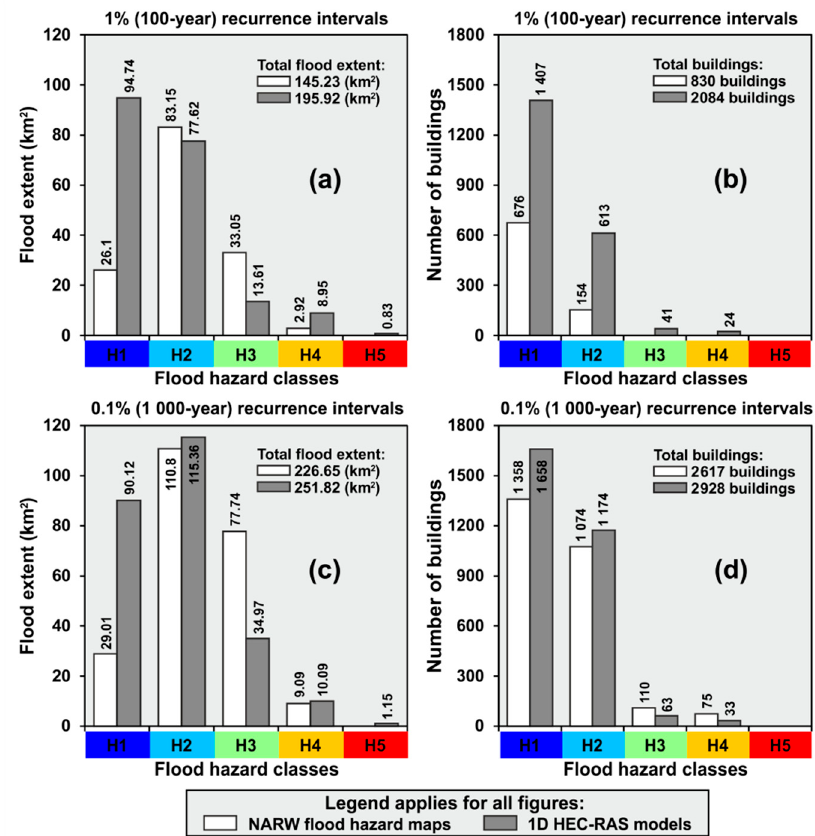
Figure 12. Comparison between official flood hazard maps provided by NARW and the maps generated based on 1D HEC-RAS modeling: ( a ) flood extent area vs. flood hazard classes computed for 1% (100-year) recurrence intervals, ( b ) number of buildings potentially affected by floods vs. flood hazard classes computed for 1% (100-year) recurrence intervals, ( c ) flood extent area vs. flood hazard classes computed for 0.1% (1000-year) recurrence intervals, and ( d ) number of buildings potentially affected by floods vs. flood hazard classes computed for 0.1% (1000-year) recurrence intervals.